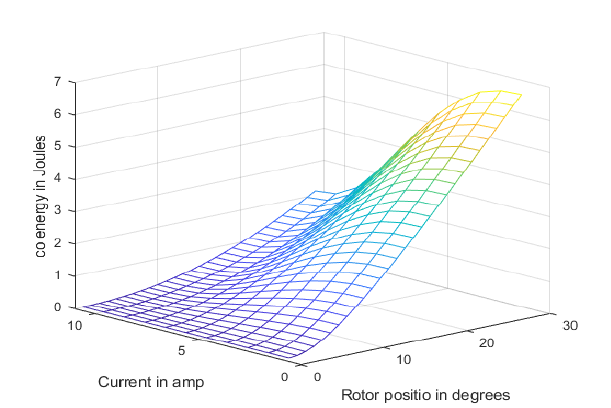
Fig. 3. Variation of Flux with rotor position and current